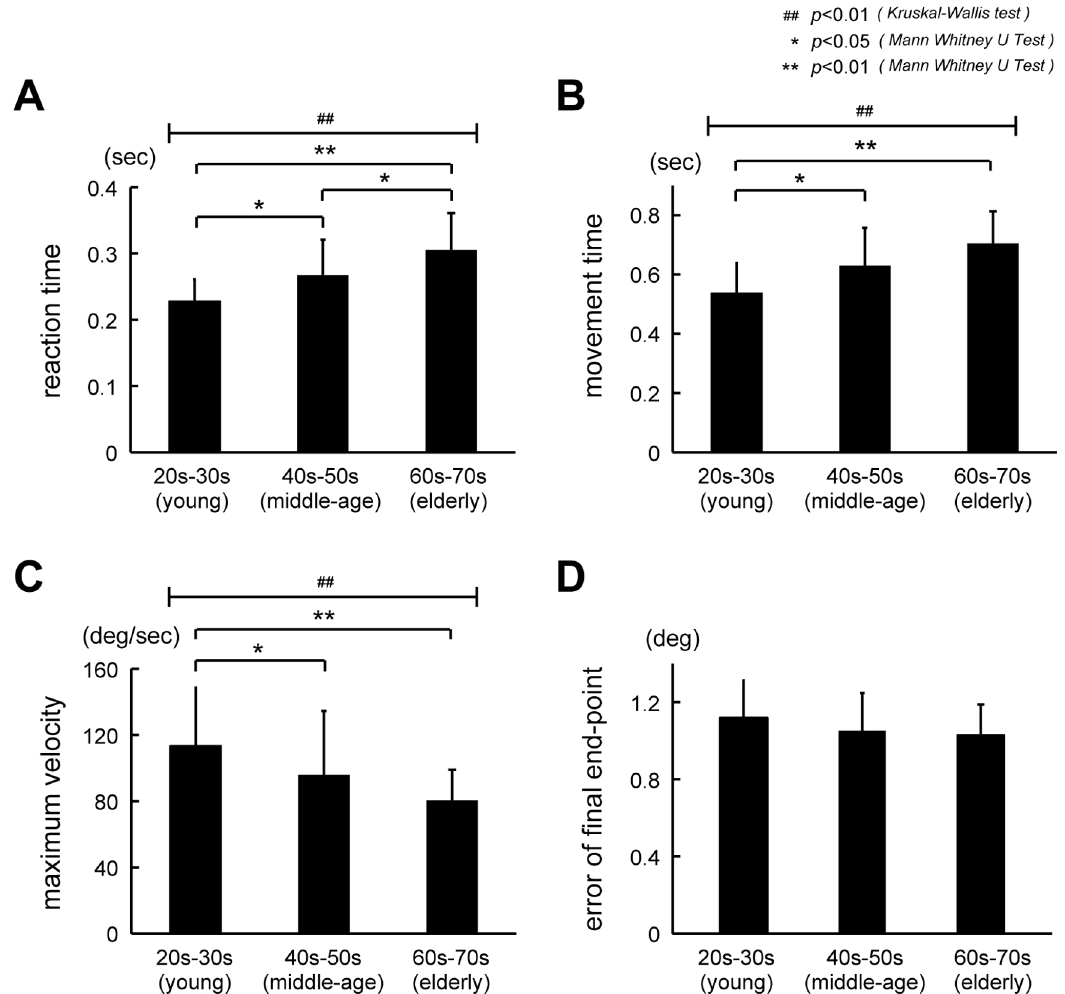
Fig 3. Age-related changes in kinematic properties for step-tracking wrist movements in terms of reaction time (RT), movement time (MT), maximum velocity (MVel), and terminal error. (A) Age-related differences in RT in the three age groups. There were statistically significantdifferences betweenall three groups (p < 1.5 × 10 − 4 , Kruskal-Wallis test; p < 0.019 for youngand middle-age;p < 0.03 for middle-ageand elderly; p < 8.0 × 10 − 5 for young and elderly, Mann- Whitney U test). (B) Comparisonof MT betweenthe three age groups. There were statistically significantdifferences betweenthe three age groups (p < 5.5 × 10 − 4 , Kruskal-Wallis test), betweenthe younggroup (20–30years old) and the middle-age group (40–50years old) (p < 0.033, Mann-Whitney U test), and betweenthe young group (20–30years old) and the elderly group (60–70years old) (p < 1.25 × 10 − 4 , Mann-Whitney U test). Note that the MT was longerfor the aged groups. (C) Comparisonof MVel betweenthe three age groups. There were statistically significantdifferences amongthe three age groups(p < 0.003, Kruskal-Wallis test), betweenthe younggroup (20–30years old) and the middle-age group (40–50years old) (p < 0.037, Mann-Whitney U test), and betweenthe younggroup (20–30years old) and the elderly group (60–70years old) (p < 8.62 × 10 − 4 , Mann-Whitney U test). Note that the MVel was lower for the aged groups. (D) Age- related changesin terminalerror. The mean error values ( ± SD) for each age group were as follows: 1.12 deg ( ± 0.2) for the younggroup (n = 16), 1.05 deg ( ± 0.2) for the middle-agegroup (n = 16), and 1.03 deg ( ± 0.16) for the elderly group (n = 17). Note that there were no statistically significantdifferences amongthe three age groups (p < 0.35,Kruskal-Wallis test). 1) Parameter 1: Error of primary submovement. We calculated the error of the primary submovement as the distance between the end (red circles in Fig 2) of the primary submove- ment and the center of the target, and compared the errors between the three groups in Fig 4. The mean values (± SD) for each age group were as follows: 3.34 deg (± 0.87) for the young